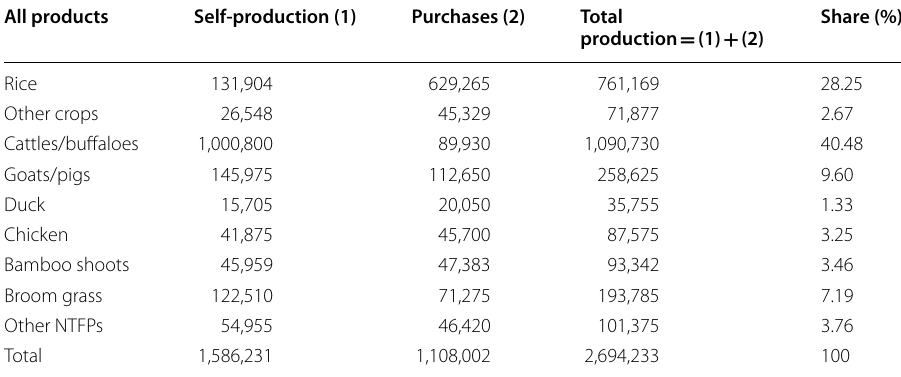
Table 8 Total production in the study village (unit: 1000 Kip). Source: Field survey data, March 8,